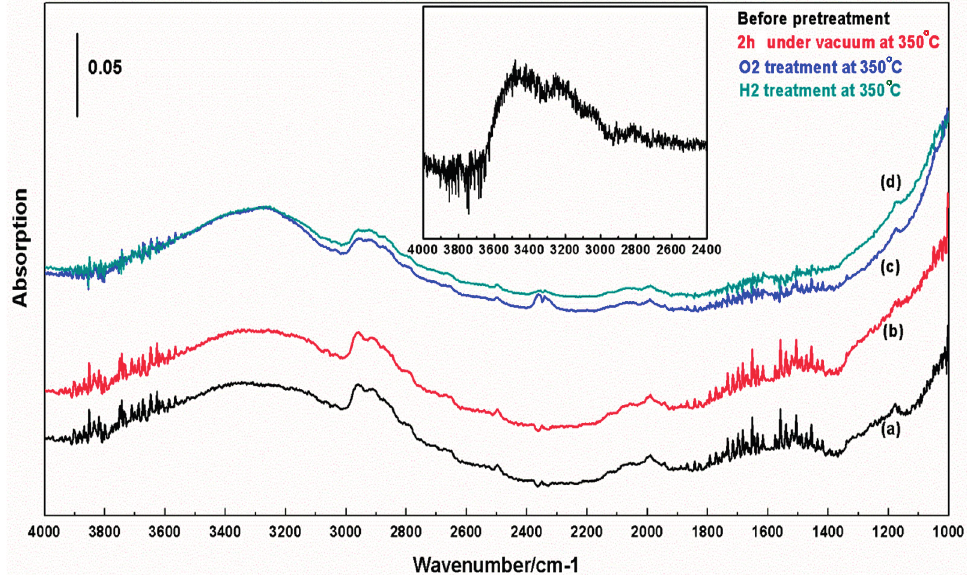
Figure 6. In situ FT-IR spectra of the c-TiNT. The collapsed NTs were prepared by calcination at 650 °C in a furnace and were allowed to cool to room temperature and introduced into the IR cell and an IR spectrum was recorded ( a ). Spectrum b was recorded after these cTiNTs were exposed to vacuum for 2 h at 350 °C. Spectrum c was recorded after the same cTiNTs were heated in O 2 for 3 h at 350 °C to produce cTiNT-O 2 . Spectrum d was recorded after the oxygen was evacuated from the cell subsequent to obtaining spectrum c and the oxidized cTiNTs were heated in H 2 for 3 h at 350 °C to produce cTiNT-O 2 -H 2 . The inset shows a cTiNT-O 2 sample that has been exposed to 10 Torr of water vapor for 15 min at room temperature. The background for all spectra was the cell with the tungsten wire grid in place but no sample on the